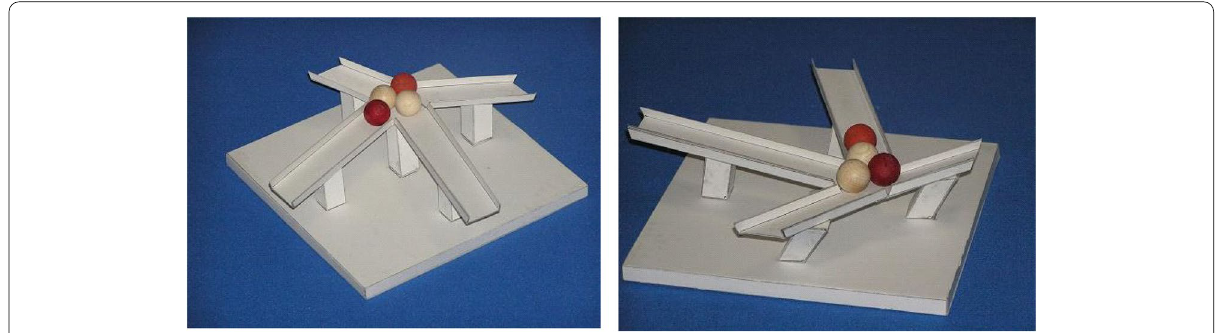
Fig. 31 The “impossible motion” object created by Sugihara